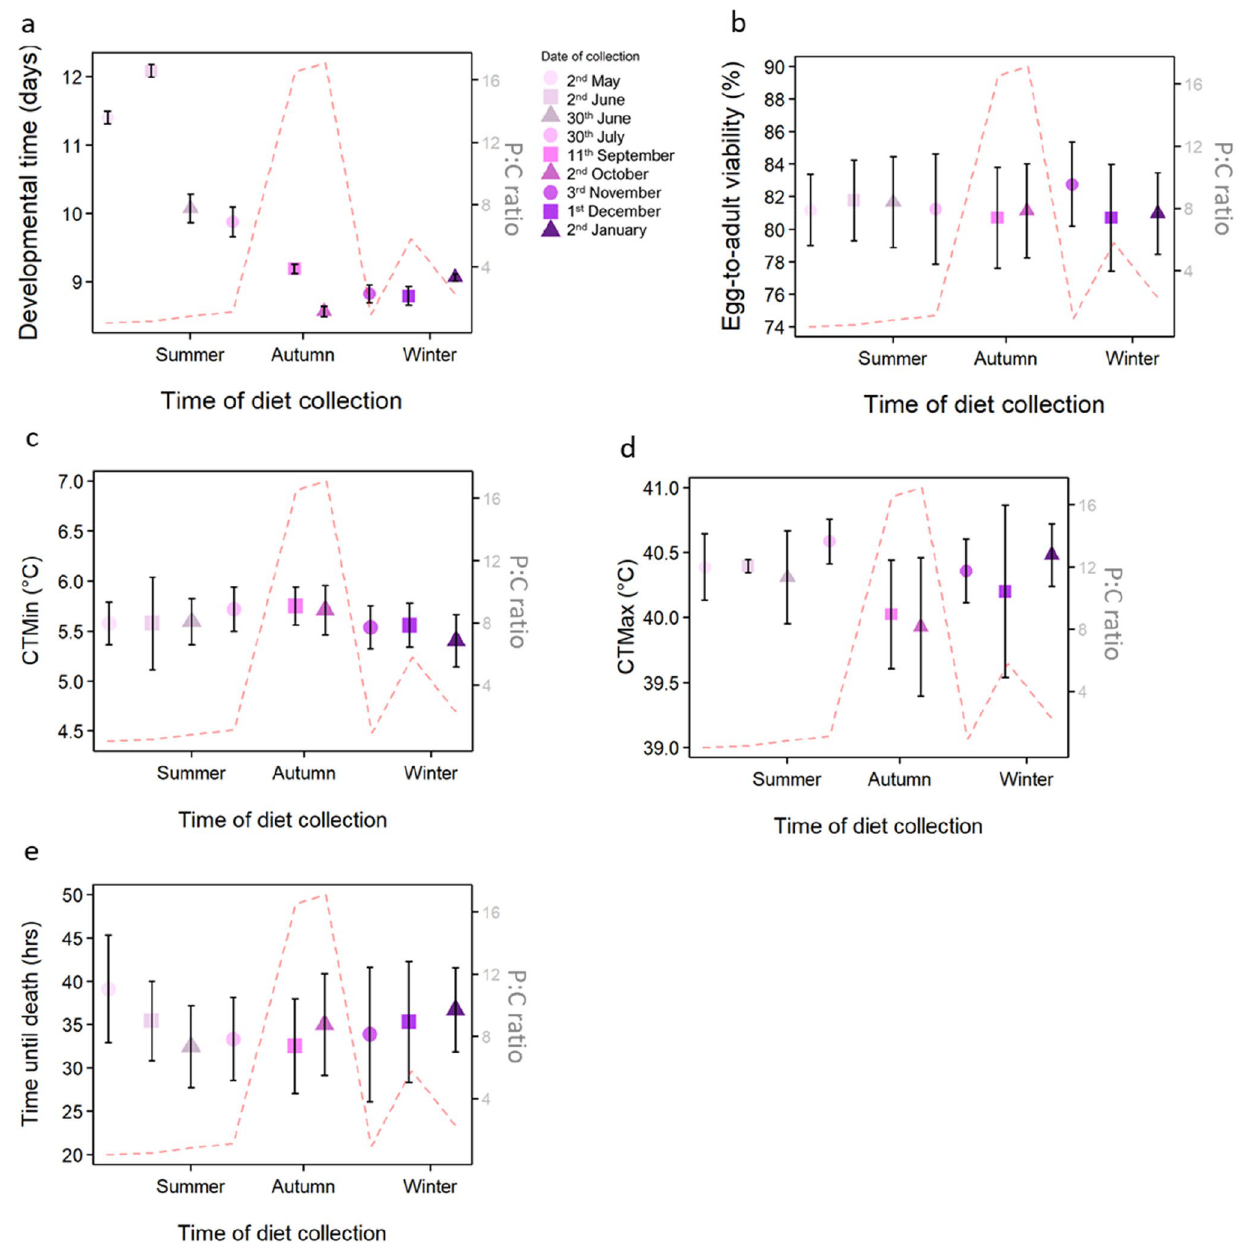
Figure 3. Results from the phenotypic assessments. Points show mean (± 95% CI). Colour and symbol code same as ( a ) for all figures. Phenotypic trait assessed shown on the left y-axis. The red dotted line represents the protein to carbohydrate (P:C) ratio of the diet (right y-axis). ( a ) Developmental time ( n = 100–120). ( b ) Egg- to-adult viability ( n = 17–19 vials). ( c ) Critical Thermal minimum (CTmin) ( n = 13–17). ( d ) Critical